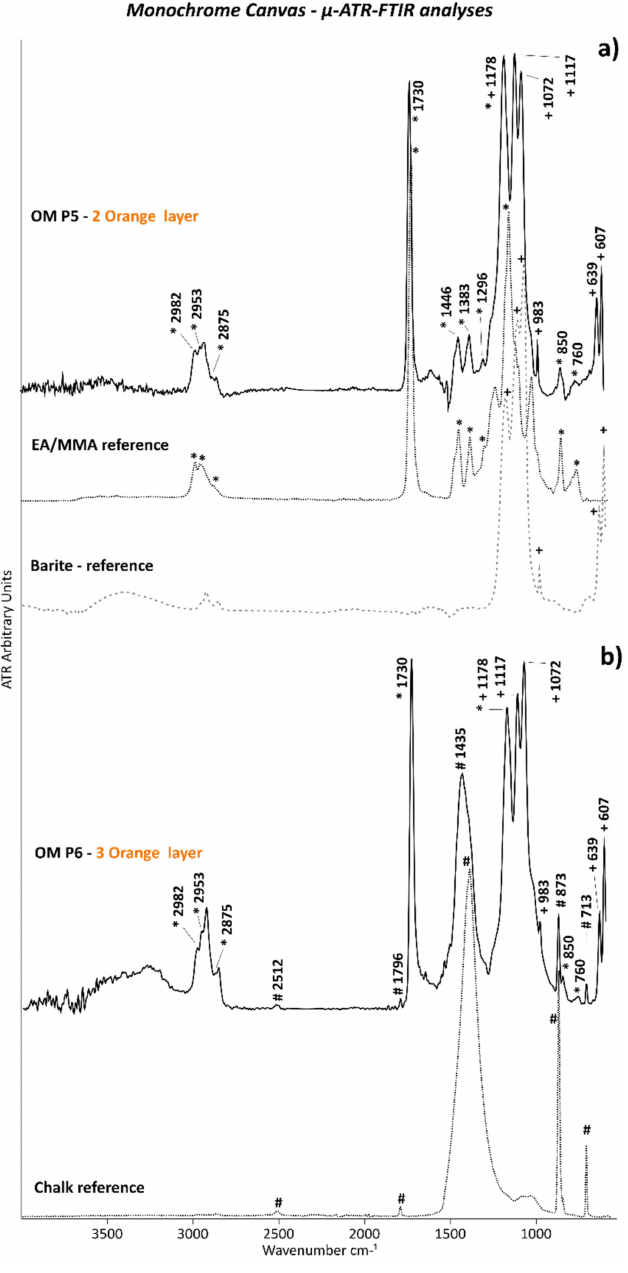
Figure 7. ATR spectra of orange layers ( a ) 2 and ( b ) 3 of OM P5 and OM P6, respectively. The ATR spectra of the EA/MMA acrylic (*), barite (BaSO 4 ) (+), and chalk (CaCO 3 ) (#) references are also